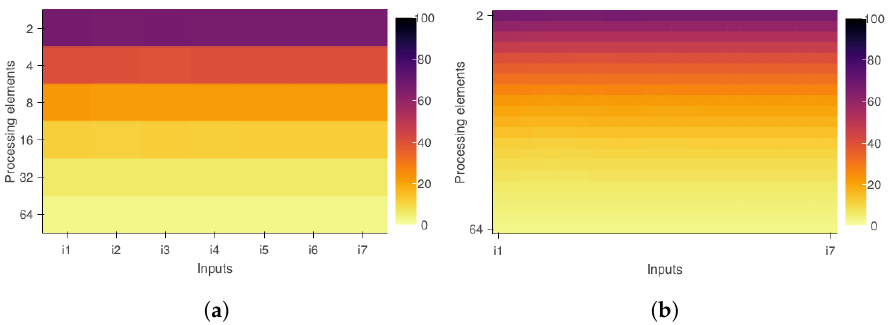
Figure 5. Visualization modes of diagrams provided by PaScal Viewer. ( a ) PaScal Viewer diagram on discrete mode. ( b ) PaScal Viewer diagram on smoothed